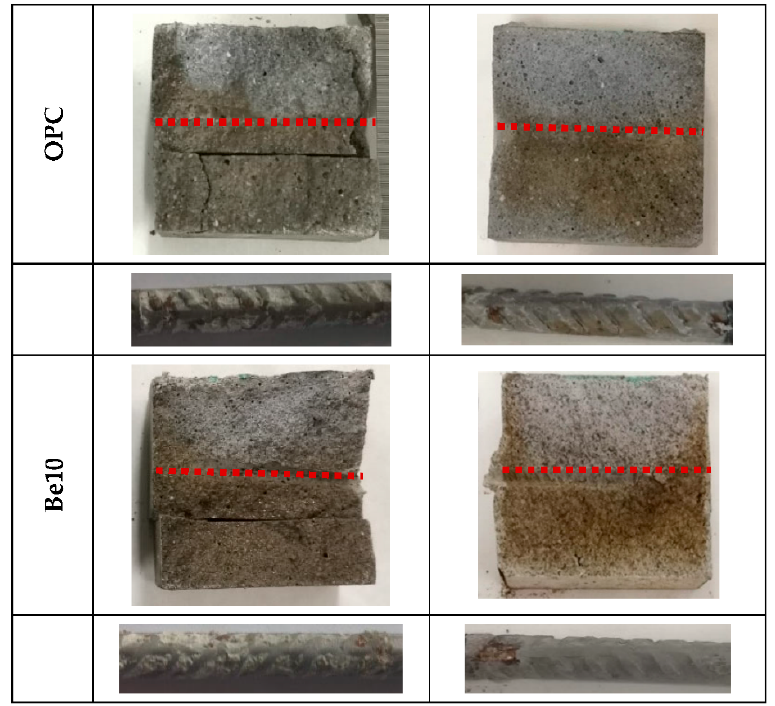
Table 3. Chloride non-steady-state non steady-state diffusion coefficient (D ns ) in reference (OPC) specimens and samples bearing 10% bentonite (Be10).